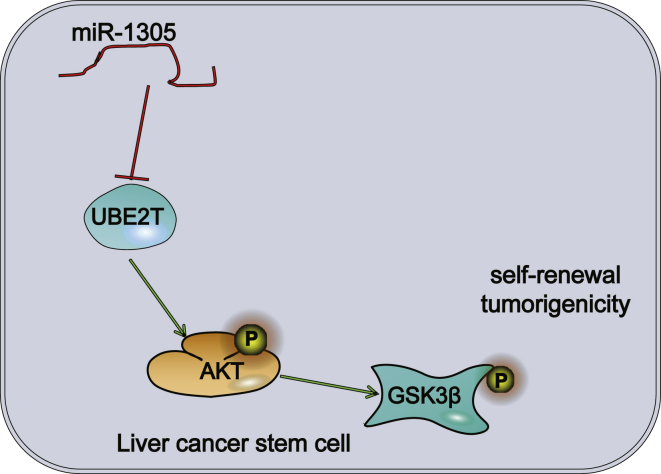
The Regulatory Mechanism of miR-1305 in the Self-Renewal and Proliferation of LCSCsmiR-1305 can downregulate the Akt-signaling pathway mediated by UBE2T, thus inhibiting the proliferation, colony formation, sphere formation, and tumorigenic potential of LCSCs.